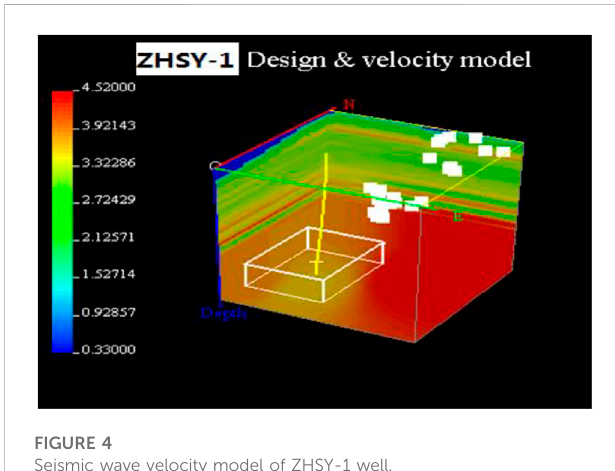
FIGURE 4 Seismic wave velocity model of ZHSY-1 well.